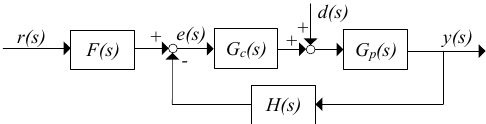
Figure 1. The structure of a two degrees of freedom proportional-integral-derivative (PID) system.